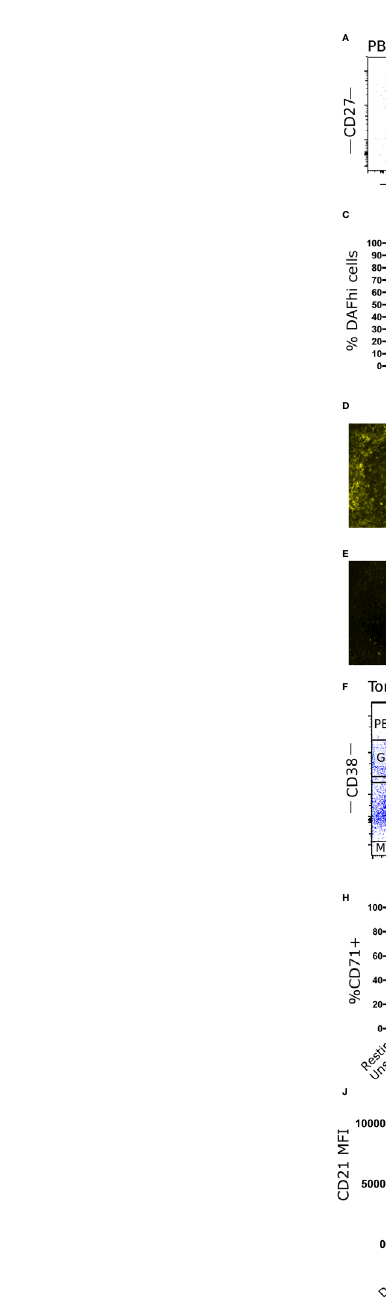
FIGURE 2 | Germinal center B cells speci fi cally downregulate DAF. (A) Representative fl ow cytometric plots and quanti fi cation of DAF expression on CD19 + CD20 + naïve (CD27 − IgD + ), unswitched memory (unsw mem, CD27 + IgD + ), switched memory (sw mem, CD27 + IgD − ), or CD27- IgD- B cells from circulation (N = 7) and (B) Tonsils (N = 8). (C) Quanti fi ed %DAFhi of indicated B cell populations. Individual dots for each sample are shown and lines indicate median with interquartile range. (D) Representative section of a non-reactive tonsillar B cell follicle stained with IgD (yellow), CD19 (blue), CXCR4 (magenta), and DAF (green). Scale bar = 100 µm. (E) Representative staining of reactive B cell follicle. Scale bar = 100 µm. (F) Representative plot for fl ow cytometric subset analysis of DAF expression on germinal center cells (GC, CD38 + , IgD − ), naïve B cells (CD38 − IgD + ), unswitched activated (unsw act, CD38 + IgD + ), memory cells (CD38 − IgD − ), and plasmablasts (PB) (CD38 ++ IgD − ) of CD19 + CD20 + tonsillar B cells. Vertical line indicates the cutoff to discriminate DAF hi from DAF lo cells. (G) Quanti fi cation of DAF expression on tonsillar B cell subsets. Individual dots for each sample are shown and lines indicate median with interquartile range. (H) Frequency of B cell subsets with high expression of the transferrin receptor CD71. Data is represented as bar graphs showing median and interquartile range. (I) Frequency of B cell subsets with high expression of Ki67. Data is represented as bar graphs showing median and interquartile range. (J) Median fl uorescence intensity (MFI) of CD21 on DAF hi and DAF lo GC B cells. (K) Quanti fi ed %CD95+ cells of DAF hi and DAF lo GC B cells. *P < 0.05; **P < 0.01 by Wilcoxon signed- rank test. Bars show median with interquartile